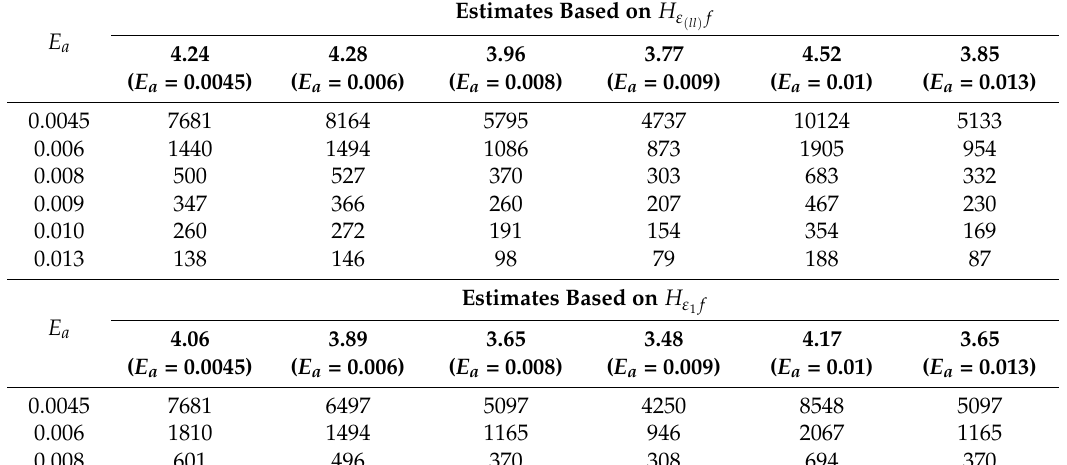
Table 10. Prediction of low-cycle lives of the superalloy GH4169 by applying H ε E a FIP.